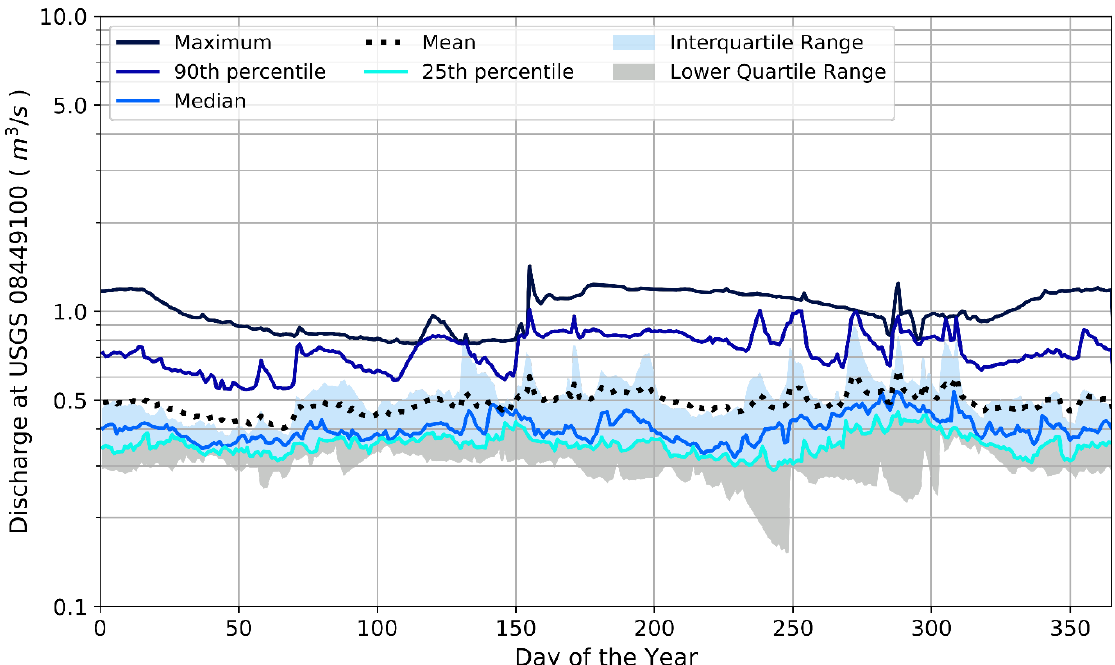
Figure A2 . Dolan Creek, USGS 089449100, Gauge Day of the Year Discharge (2011-11-17 through 2019-11-06). Lower quartile and interquartile ranges are relatively flat and consistent width bands even for only eight years of data. This suggests that spring discharge is an important component of the Dolan Creek gauge record. Dolan Springs, upstream of the gauge, provides a significant portion of the year around flow.